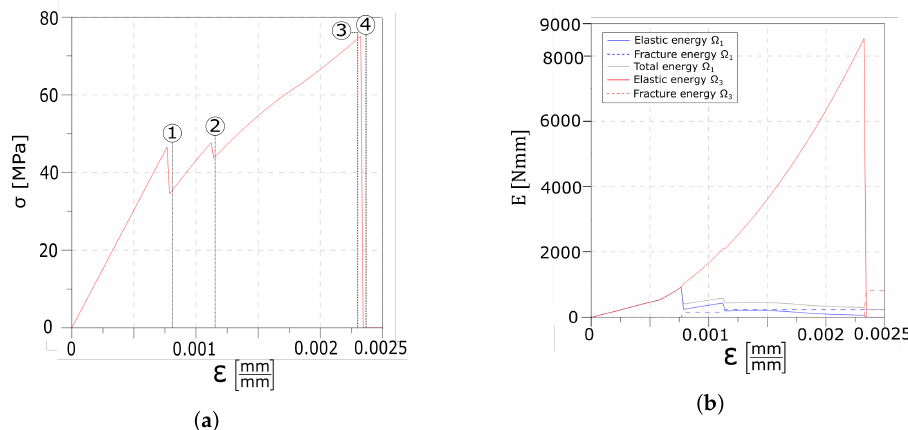
Figure 9. Numerical results of the UD E2 1500 test: global response. ( a ) Global stress–strain response of the laminated glass beam. ( b ) Global evolution of the energy contributions.